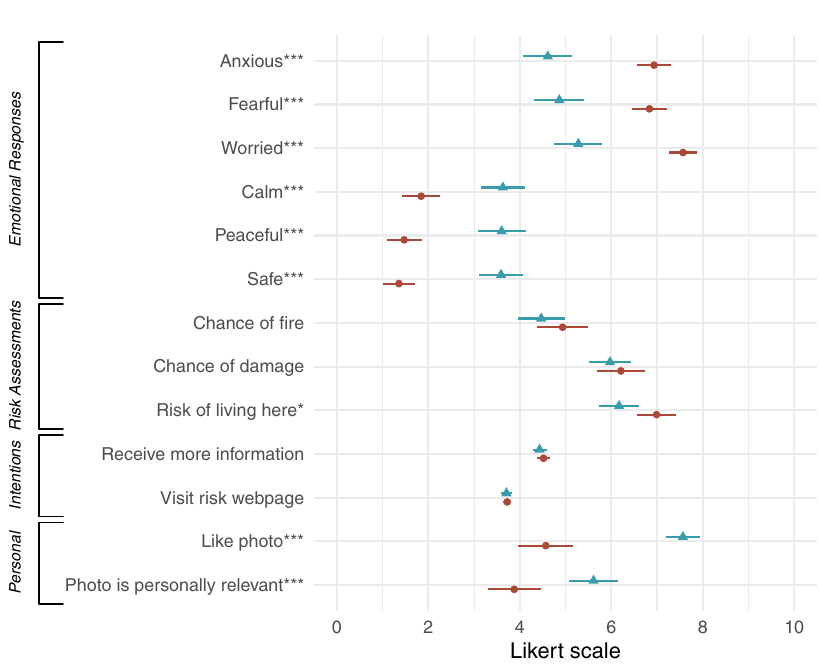
Fig. 2 Differences between self-reported responses to the fl ames photo and status quo photo in the online experiment. Red circles represent mean responses to the fl ames photo; blue triangles represent mean responses to the status quo photo. Lines show ± 1 standard error of the mean. Emotional responses and personal preferences were rated on a Likert scale from “ Not at all ” (0) to “ The most possible ” (10). Risk assessments were rated from “ No chance ” (0%) to “ For sure ” (100%) and “ Not risky at all ” (0) to “ Extremely risky ” (10). Behavioral intentions were rated on a 5-point Likert scale from “ Extremely unlikely ” (1) to “ Extremely likely ” (5) and doubled for this fi gure. p -values are from t-tests and adjusted for multiple comparisons using the